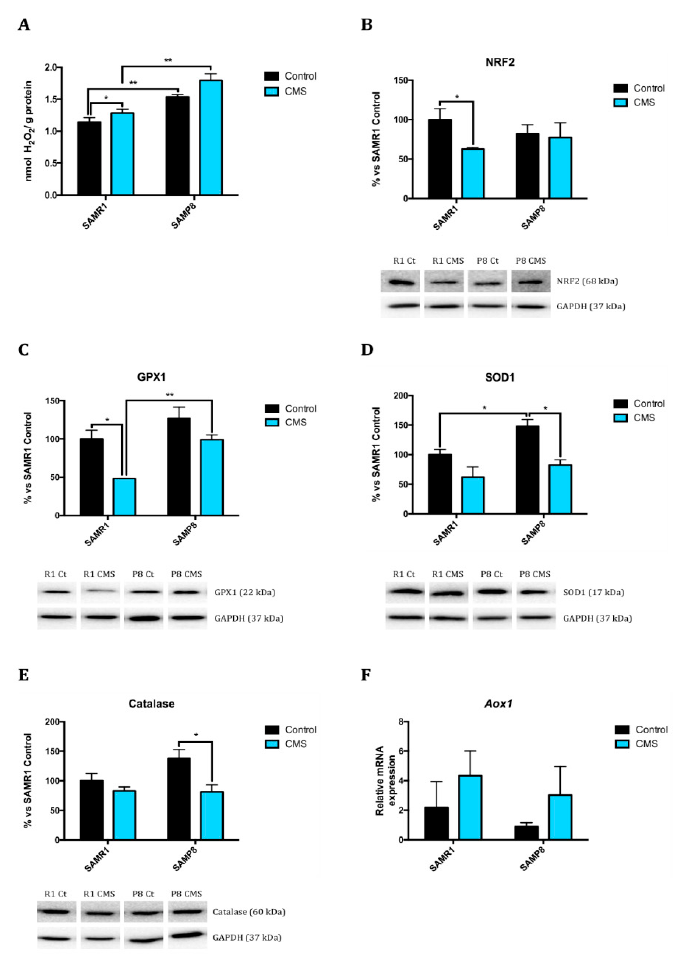
Figure 3. Changes in cellular oxidative stress after CMS. Representative OS measured as